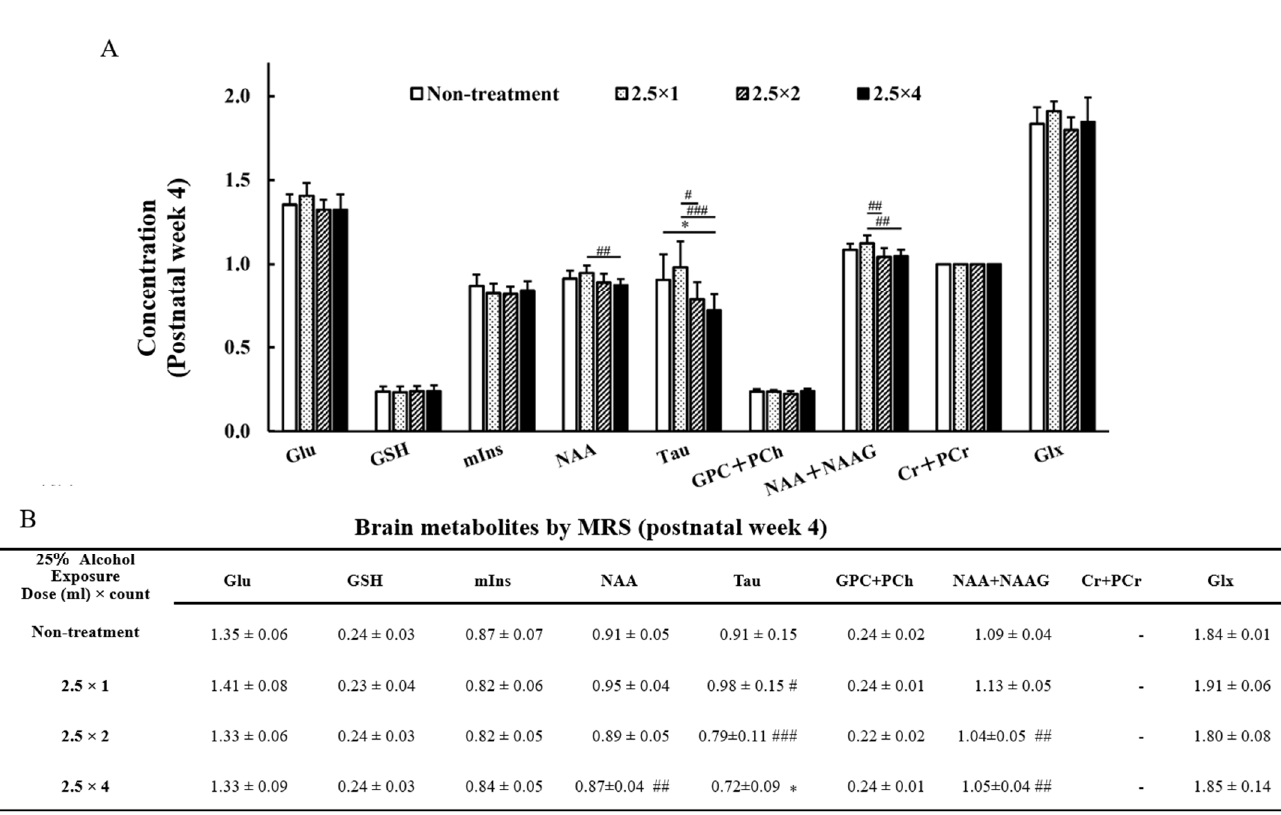
Figure 5. MR spectrum of 4- and 8-week-old rats analyzed using LCmodel.